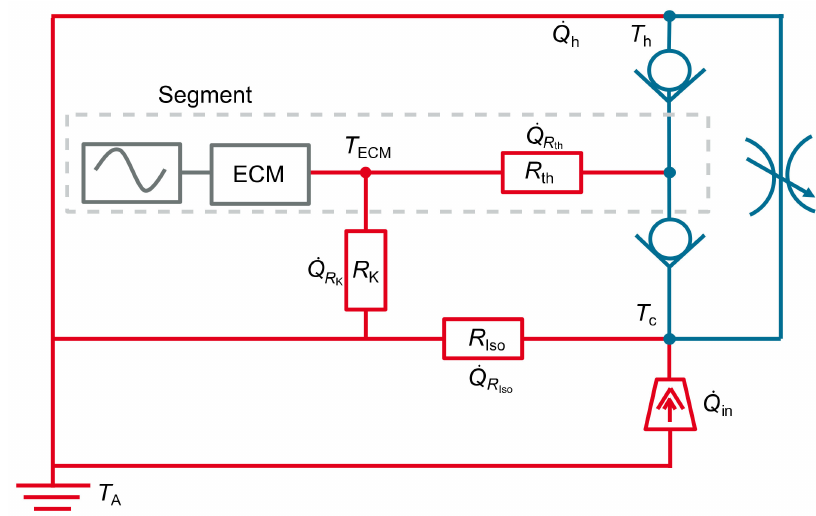
. Q R flows into the evaporator via this resistance. Iso . Q in . The evaporator is connected to . Q R . The ECM K . Q R . The fluid flows from the th . Q h is dissipated